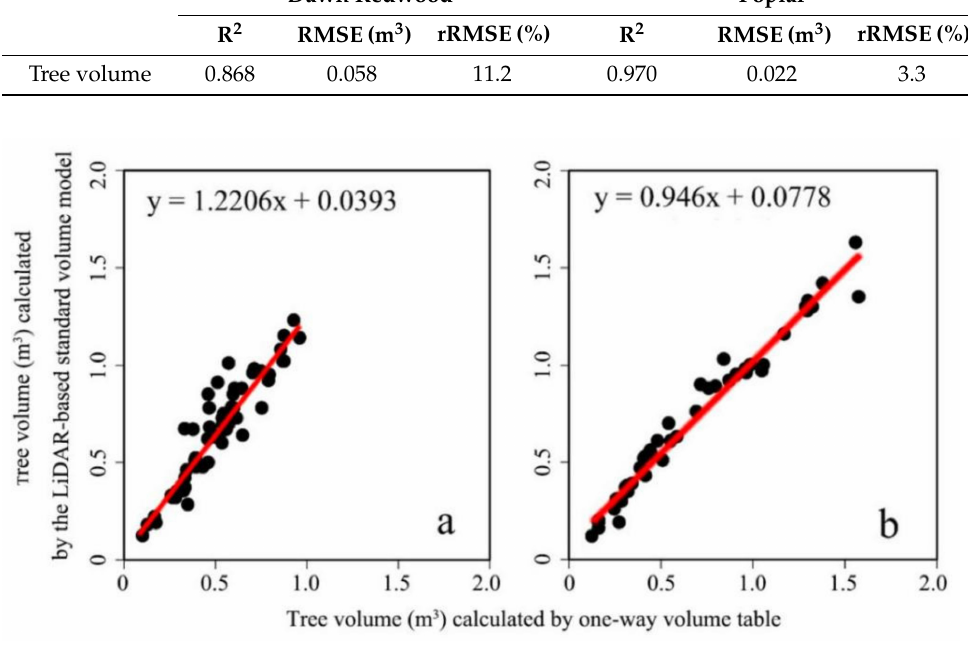
Figure 7. Tree volumes calculated with the LiDAR-derived standard volume equations of dawn redwood and poplar vs. tree volumes obtained by finding them in the local single-entry volume table. ( a ) Dawn redwood, ( b )